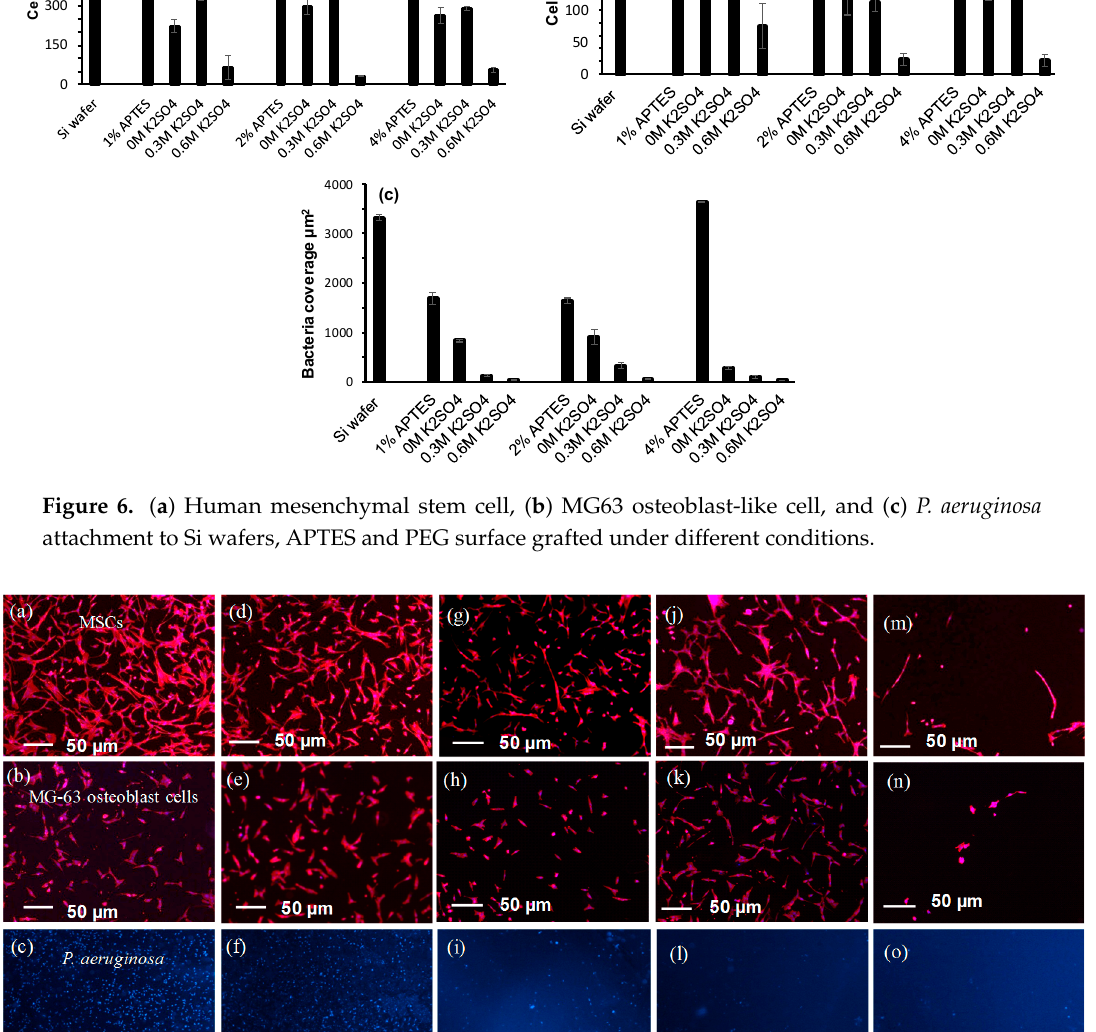
Figure 8. SEM images of P. aeruginosa attachment to: ( a ) Si wafer control, ( b ) 4% APTES, ( c ) 4% APTES_PEG 0 M K 2 SO 4 , ( d ) 4% APTES_PEG 0.3 M K 2 SO 4 , and ( e ) 4% APTES_PEG 0.6 M K 2 SO 4 . 4. Discussion In this study, we have changed the PEG chain grafting density in several ways by using different APTES concentrations to generate reactive surfaces with different concentrations of amine groups and by grafting PEG under different solution conditions to vary the surface density of polymer chains. These surfaces were then tested in bioassays that included studying protein adsorption, mammalian cell (MSC and MG63 osteoblast) and bacterial ( Pseudomonas aeruginosa ) attachment. The highest PEG coverage was achieved by grafting at the ‘cloud point’ (CP) of the PEG. This is attributed to a reversible phase change of PEG molecules under these specific conditions due to rupturing the hydration surrounding the PEG chains through anion (SO 42 − ) interactions with the PEG molecules that is enhanced at high temperatures. Under these poor solvent conditions, there is a reduction in the repulsion between the PEG chains and a lowering of the radius of gyration of the individual molecules, which results in a maximum packing density, generating very high PEG graft densities if there is a sufficiently high concentration of reactive functional groups on the modified surface [26]. In addition, different densities of PEG were obtained depending on different concentrations of APTES used for surface functionalisation, i.e., a variable concentration of surface NH 2 groups was generated, and, at the highest density of APTES, a sufficiently high PEG density was achieved when combined with CP grafting (0.6 M K 2 SO 4 and 60 °C). Previously, low protein adsorption was observed by grafting of PEG under lower critical solution conditions [37–39,43]. On the other hand, many studies of PEG grafting have used conditions in which the PEG chains were highly solvated and therefore not able to produce a high density of grafting; those studies observed a reduction, but not exclusion, of protein adsorption on the surface, but complete elimination of adhesion by PEG is theoretically possible at high chain densities [44–46].